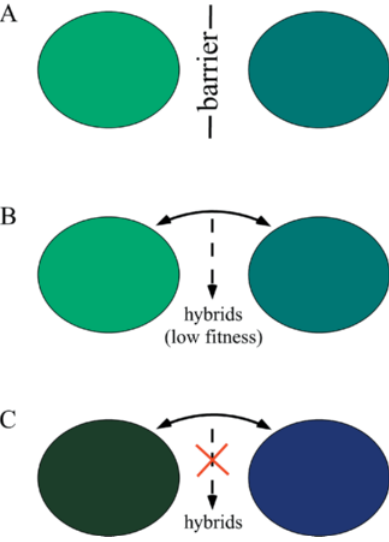
Figure 1. Schematic Diagram of Reinforcement (A) Populations diverge by evolving separately for a period of time in allopatry (separated by a geographic barrier). Populations may still be completely compatible in their mating characteristics, or these may also have diverged slightly (represented in the fi gure by the differences in color). (B) Secondary contact